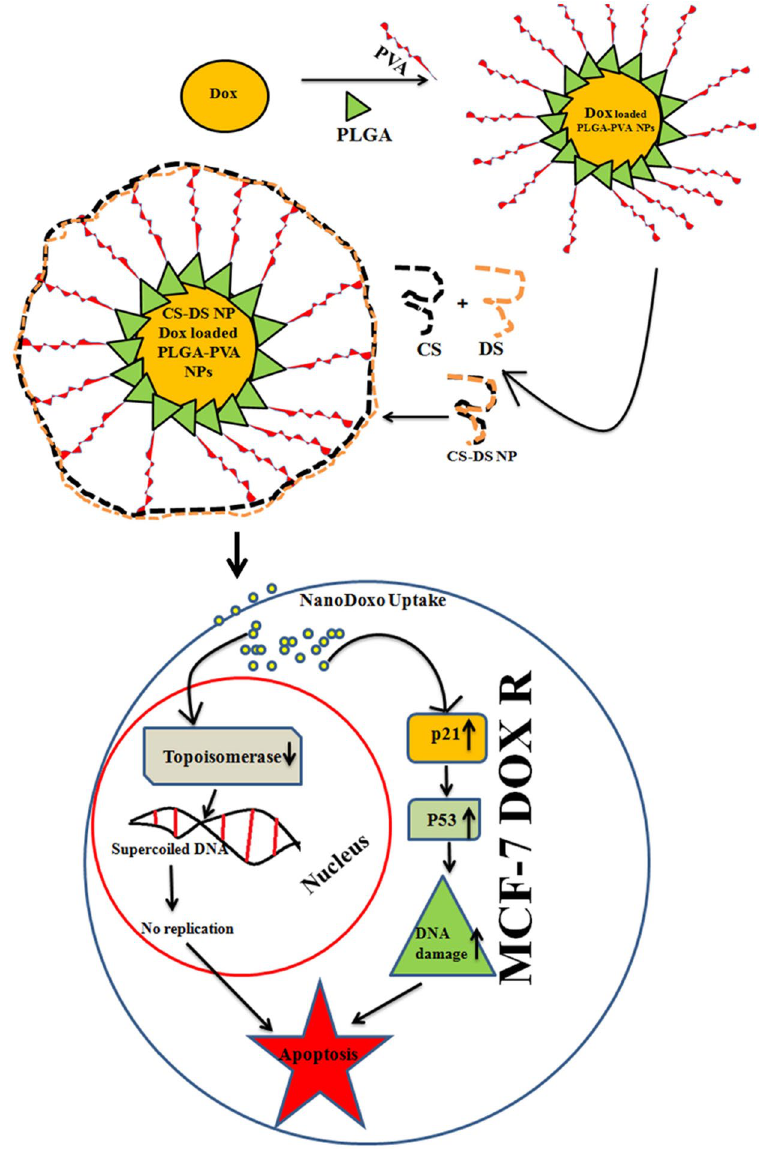
Figure 6. Graphical representation showing the formation of CS–DS coated DOX loaded PLGA-PVA NP and its apoptotic activity in MCF-7- DOX-R cells. NP enters into the nucleus and inhibits the topoisomerase activity. Inhibition of topoisomerase activity increases the DNA damage and ultimately leads to cell